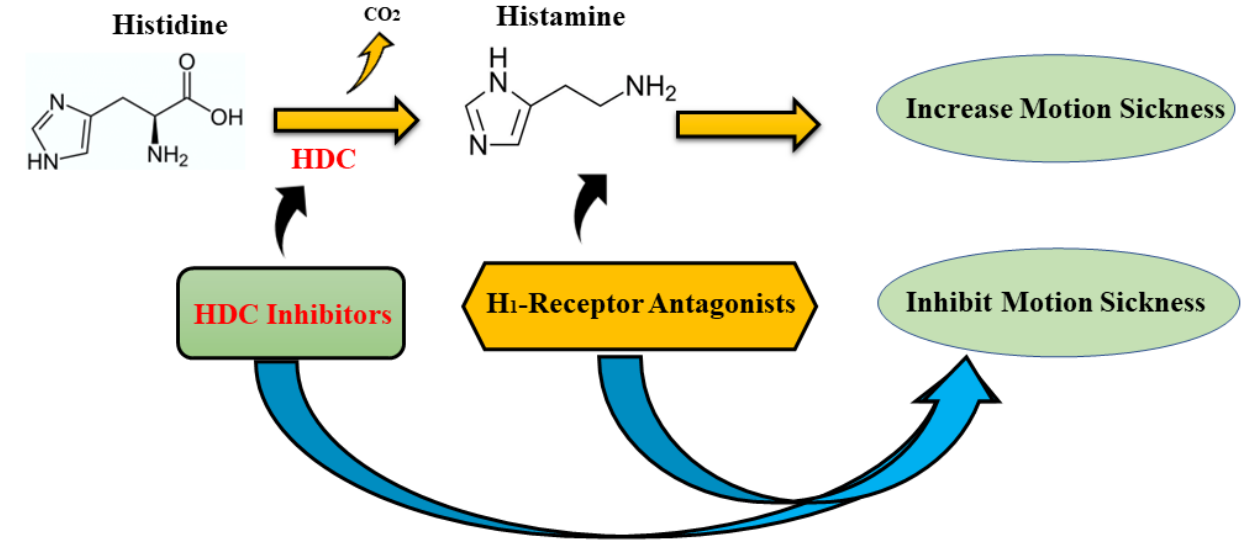
Figure 3. Histamine is synthesized from the amino acid histidine via histidine decarboxylase (HDC) enzyme [74]. MS can be successfully inhibited by the effect of HDC inhibitors, or/and first-generation histamine H1-receptor antagonists (H 1 -receptor antagonists).